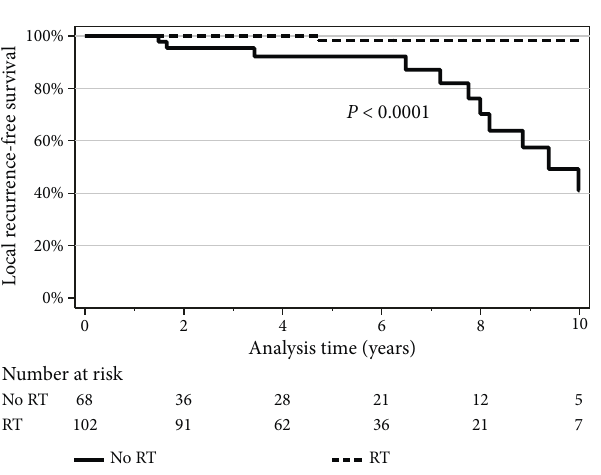
p 0 . 21 . The 10-yr ( (cid:29) )